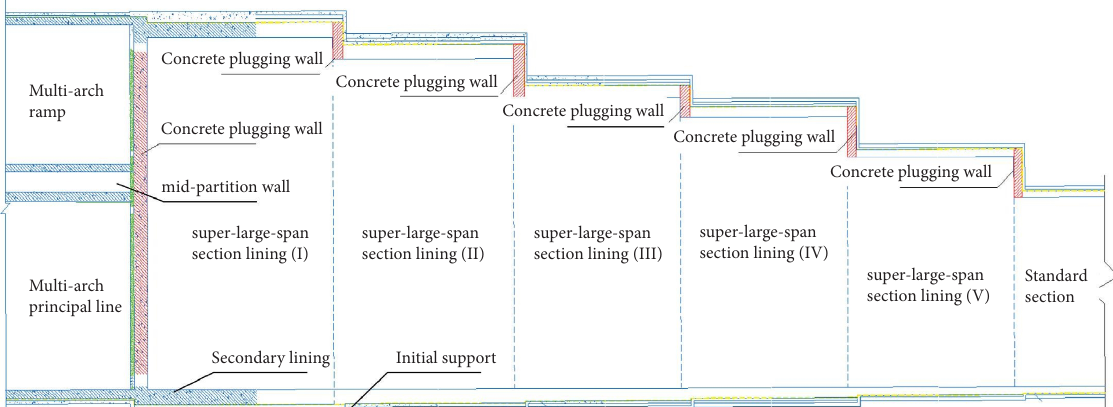
Figure 11: Plan view of plugging walls.